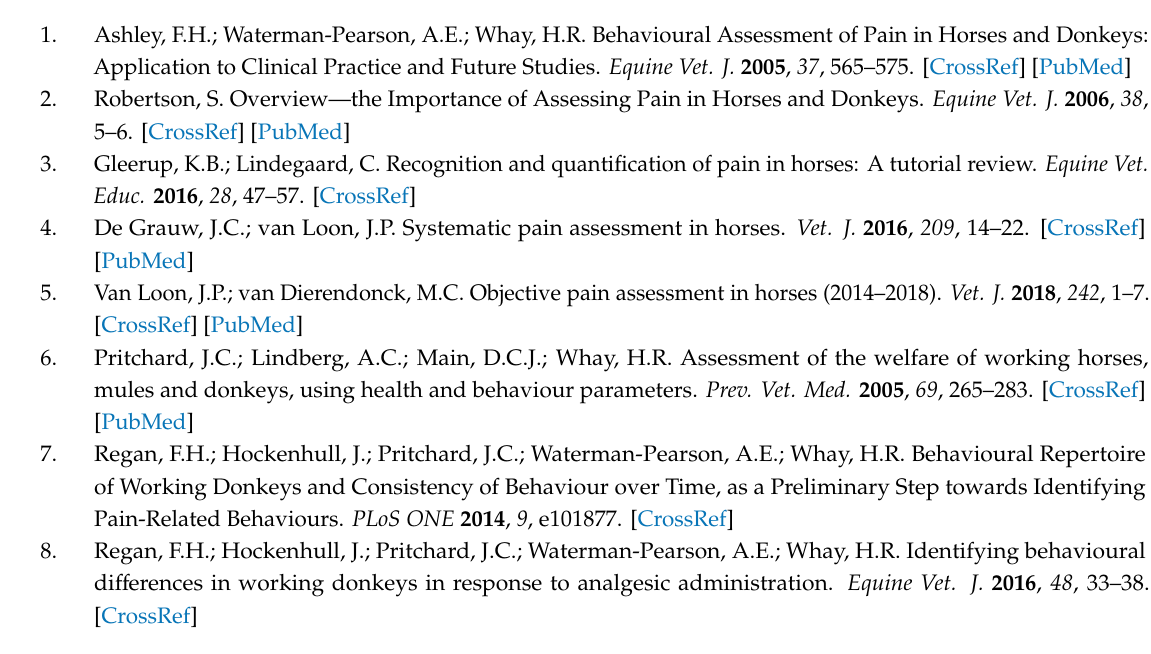
Table S1: Details on patient donkeys, Table S2: Details on control donkeys, Table S3: Age comparisons, Table S4: Donkey patient EQUUS-DONKEY-COMPASS scores, Table S5: Donkey control EQUUS-DONKEY- COMPASS scores, Table S6: Donkey patient EQUUS-DONKEY-FAP scores, Table S7: Donkey control EQUUS- DONKEY-FAP